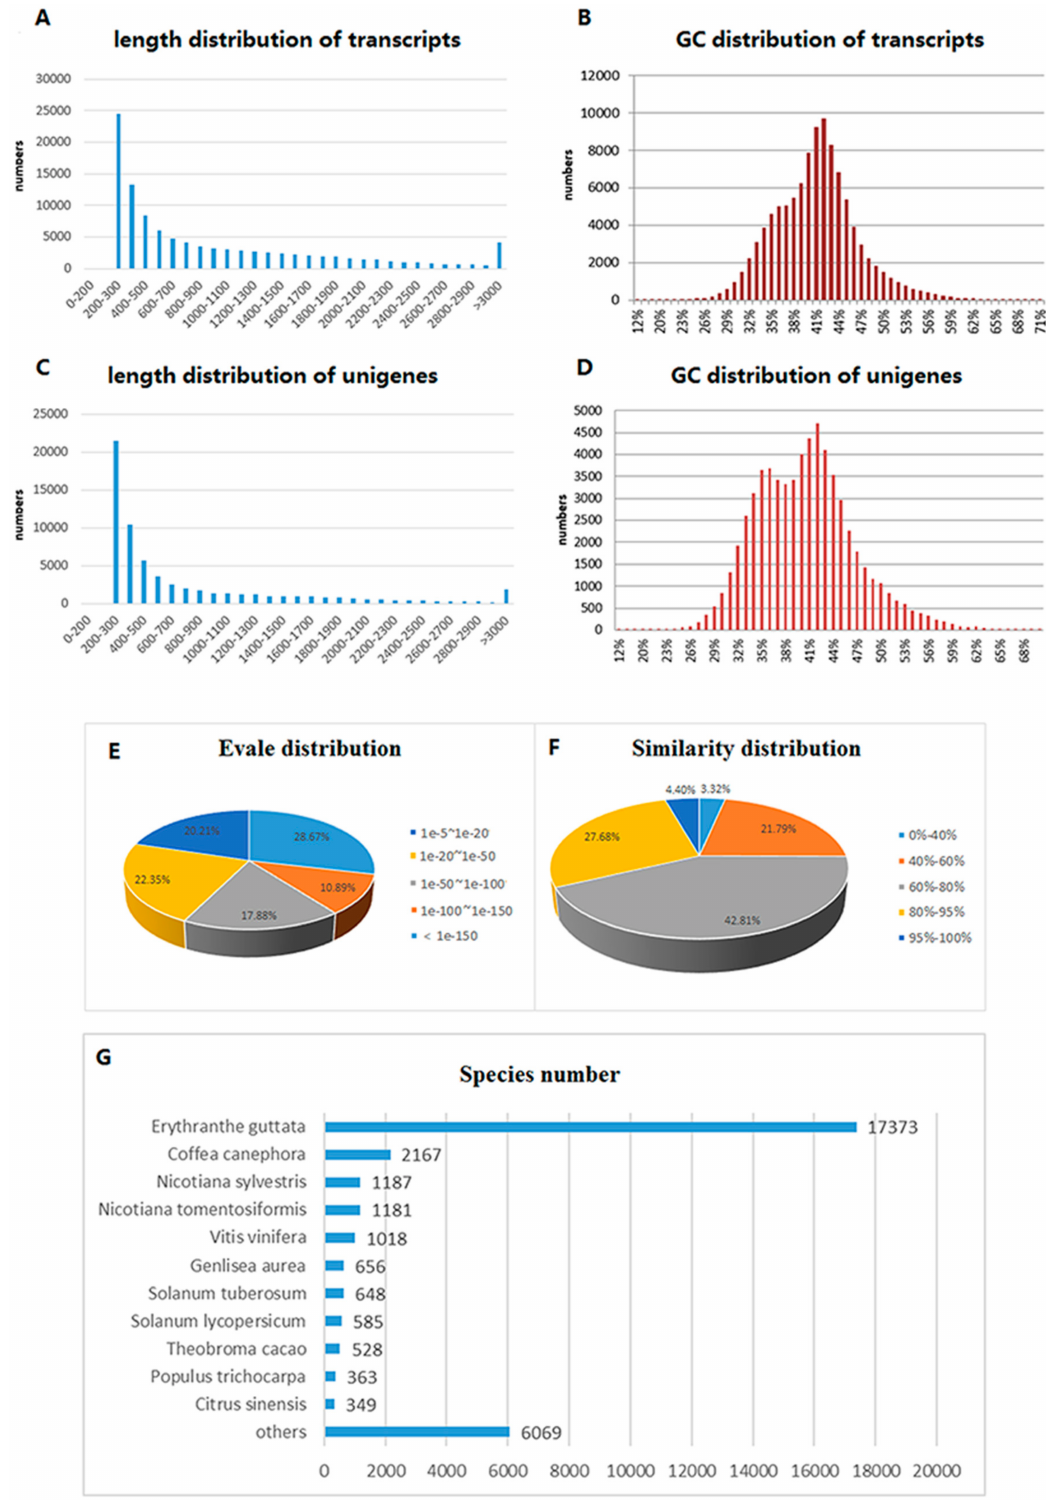
Figure 1. Overview of the de novo assembly of transcriptome sequencing in Perilla frutescens and annotation based on a non-redundant (NR) protein database. Length ( A ) and GC distribution ( B ) of transcripts; length ( C ) and GC distribution ( D ) of unigenes are shown; ( E ) e -value distribution of BLAST hits for the assembled unigenes; ( F ) Similarity score distribution of the top BLAST hits for the assembled unigenes; ( G ) Species distribution of the top BLAST hits for the assembled